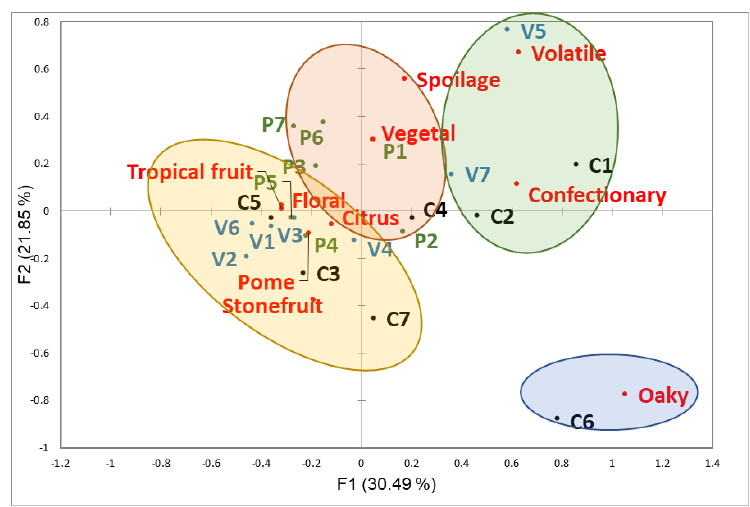
Figure 4. CA plot showing wine experts’ UFP data. Ellipses identify groups according to k-means clustering. Varietal wines are shown in different colors.